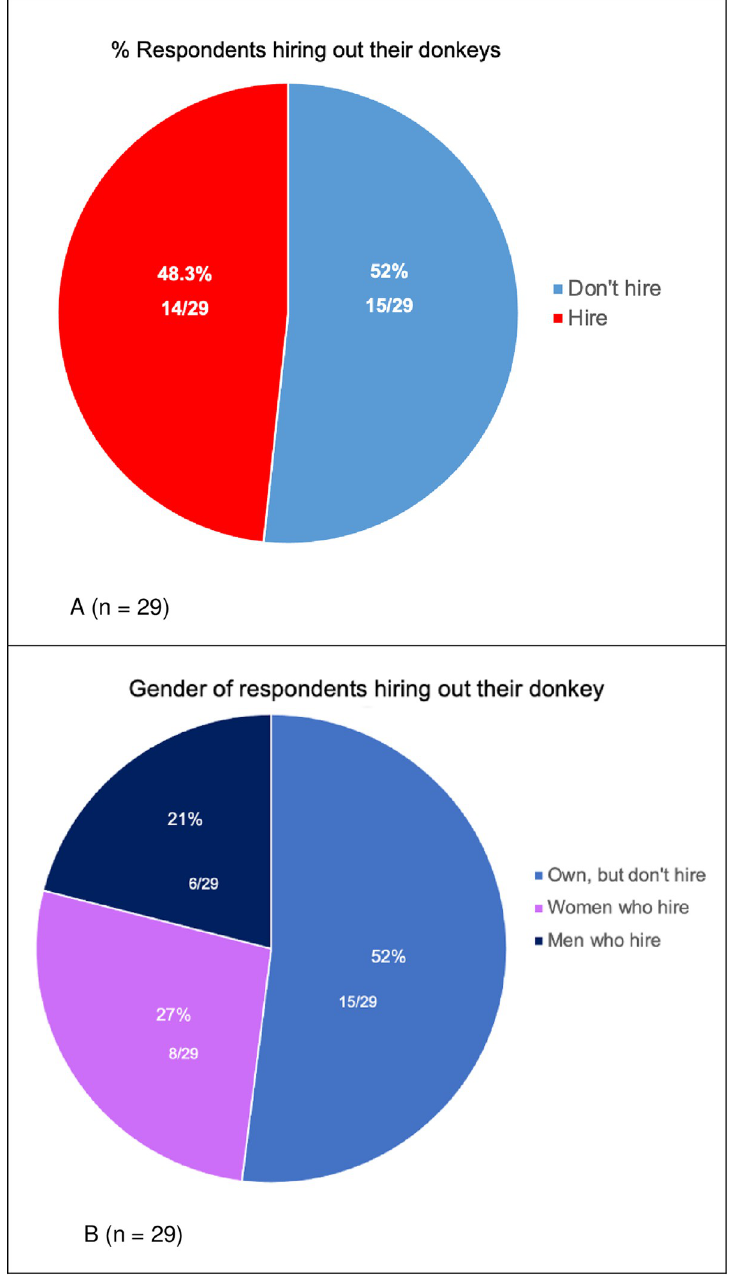
Fig 6. Hiring donkeys out for income. Source: Maggs, 2022 [1]. donkeys, twenty seven per cent were women compared with twenty one per cent men (Fig 6B). Rich, thick thematic analysis provided further details of additional methods of generating income using a donkey and the additional services they provide that DOs value. This is illumi- nated by this case study with a female in-depth interviewee.